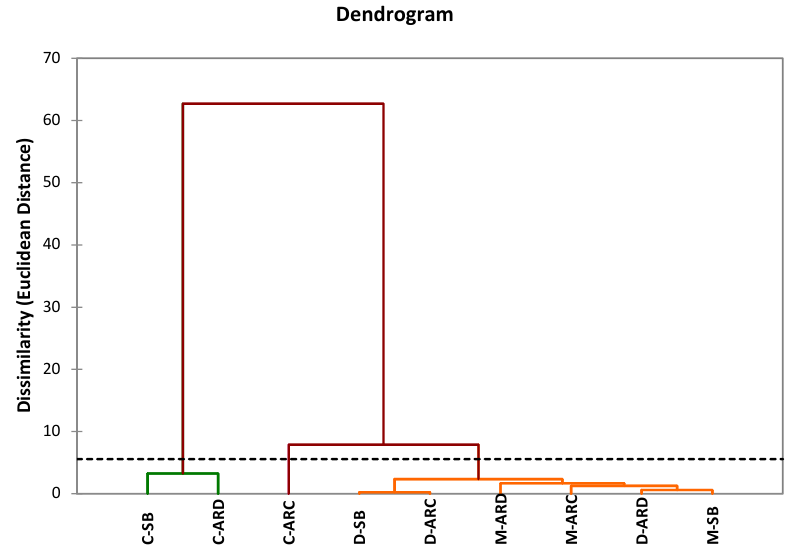
Figure 6. Dendrogram of agglomerative hierarchical clustering (AHC) grouping yogurt samples under the different environments. Different colored lines indicate different groups of yogurt samples given by AHC analysis. The description of the treatment’s labels can be found in the footnote of Table 2.